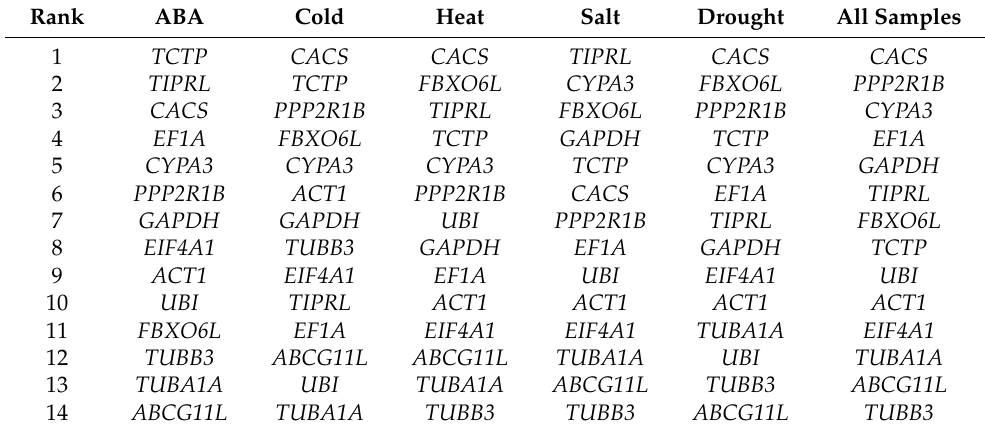
Table 3. Comprehensive rankings of fourteen candidate reference genes calculated using